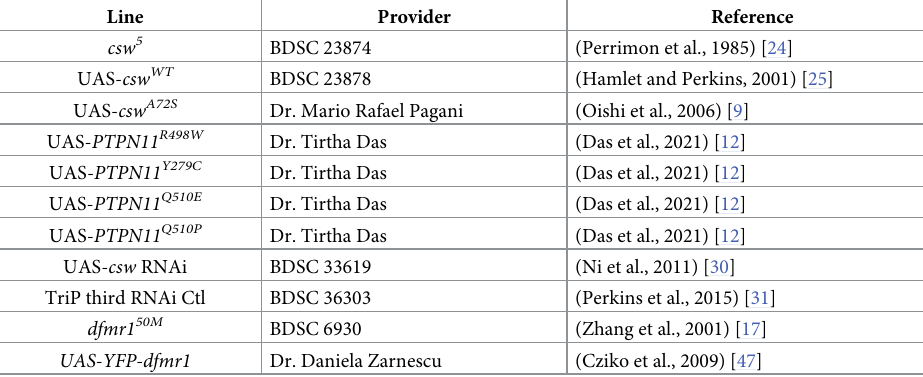
Table 1. Drosophila mutant and transgenic lines used in this